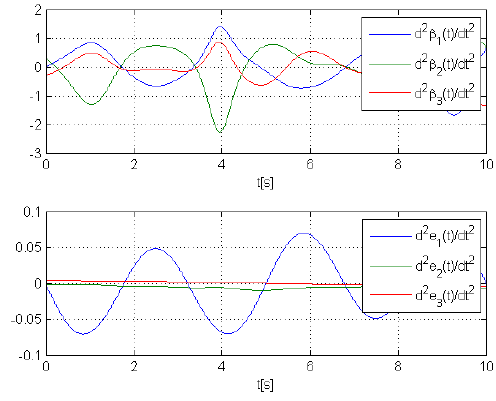
( ) t   and the related error ( ) t   and the related error . β ( t ) and the related error ( ) t   and the related error